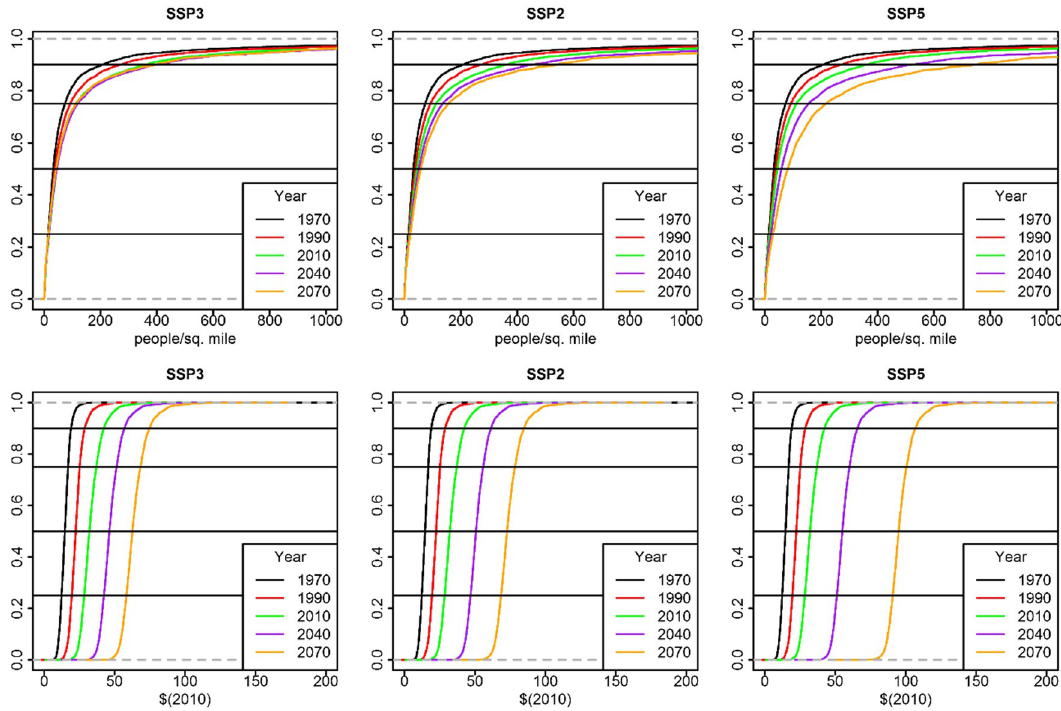
Fig 2. Population and per capita personal income distributions. The cumulative distribution of (A) county population density, and (B) county per capita personal income, for the United States for historical (1970, 1990, 2010) and projected (2040, 2070) years for three Shared Socioeconomic Pathways SSP3 (low growth), SSP2 (moderate growth), and SSP5 (high growth).